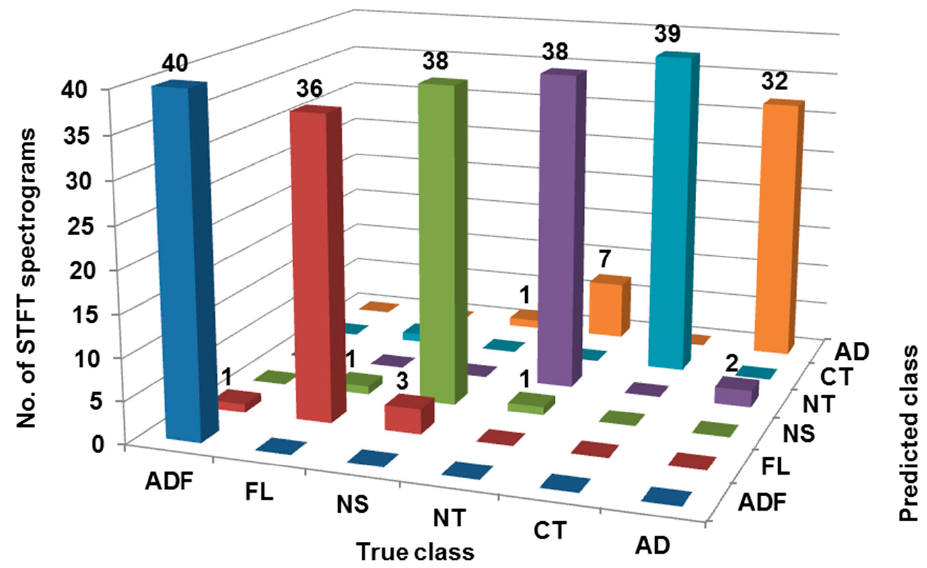
Figure 6. Confusion matrix considering cross-validation mode (ADF: All defect free (healthy), FL: Flank wear, NS: Nose wear, NT: Notch, CT: Crater, AD: All defective).